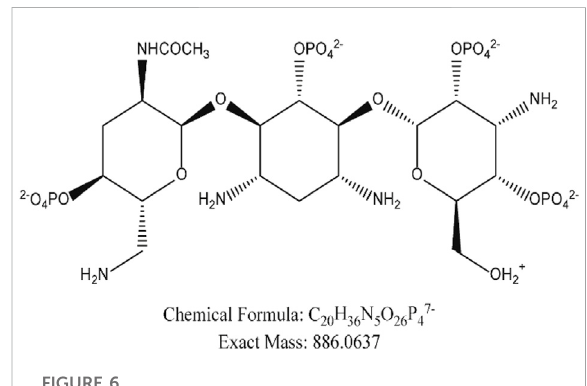
FIGURE 6 Chemical structure modi fi ed by tobramycin